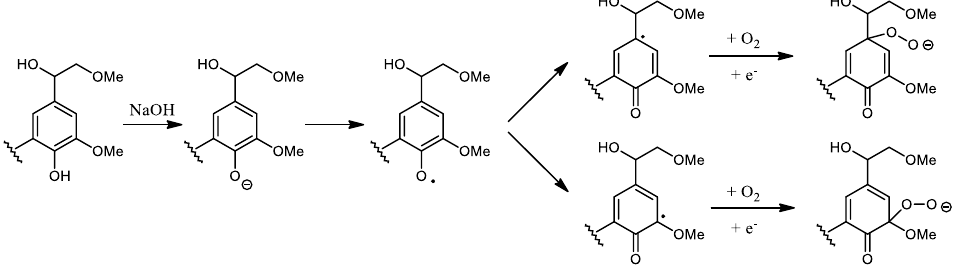
Figure 1. Insertion of oxygen on several positions of the phenolic structure of